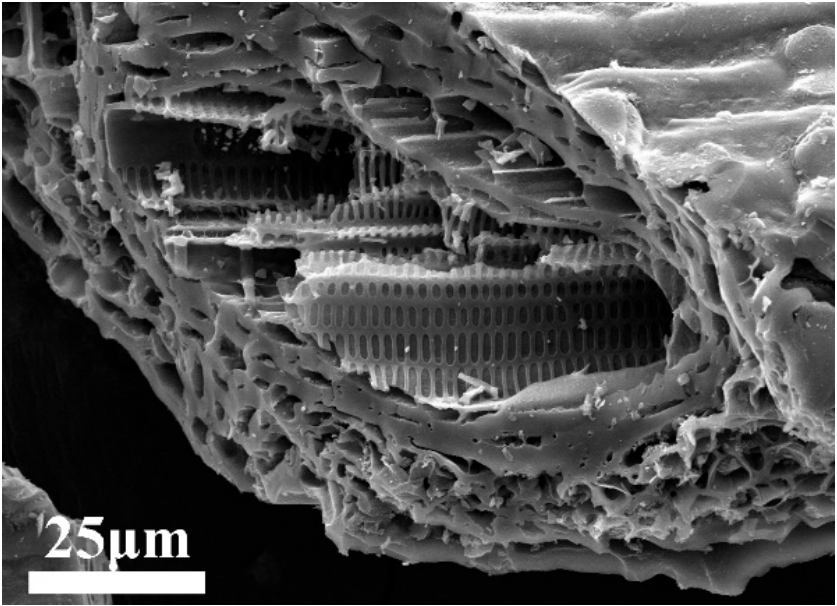
Figure 2. SEM image of microstructure morphology for flaky leaves.